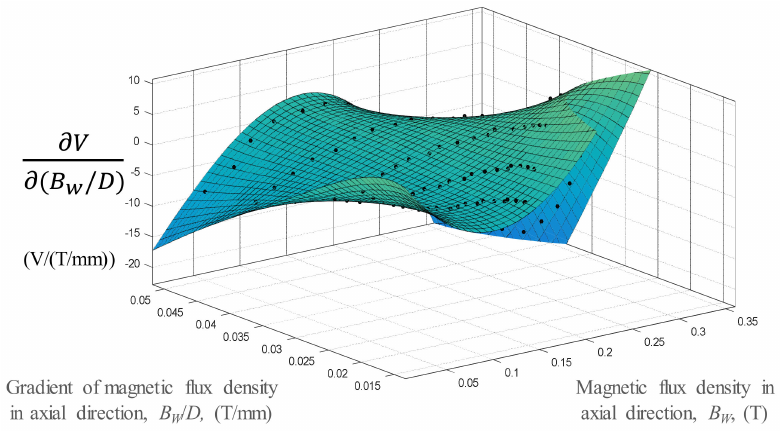
Figure 15. Sensitivity analysis of the variation in B w /D-V with B w /D and B w